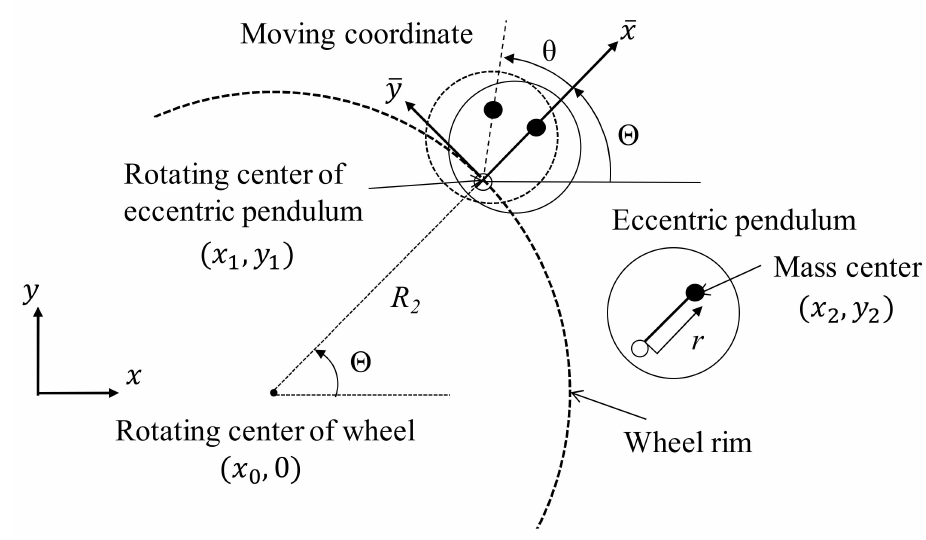
Figure 1. Eccentric pendulum installed on a wheel